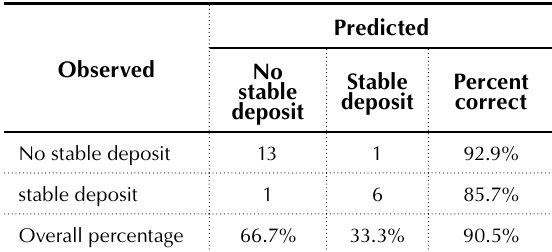
Table 31. Percentage classification of stable